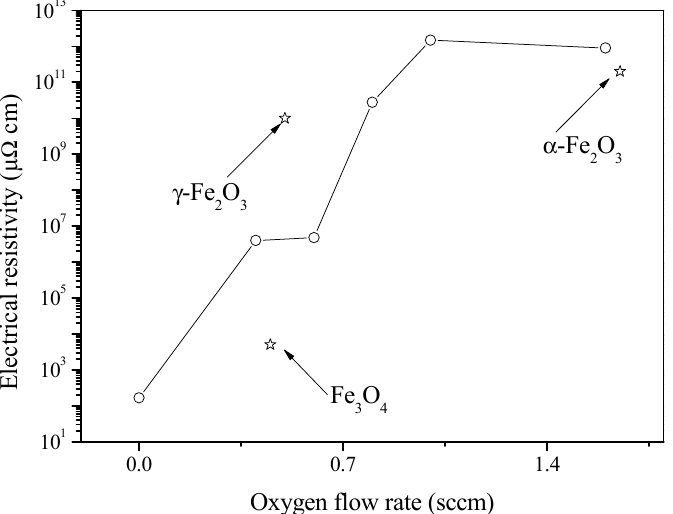
Figure 5. Influence of the oxygen flow rate on the electrical resistivity of Fe-O-N coatings deposited with 8 sccm. The star symbol is related to the electrical resistivity of amorphous iron oxide film deposited without nitrogen.